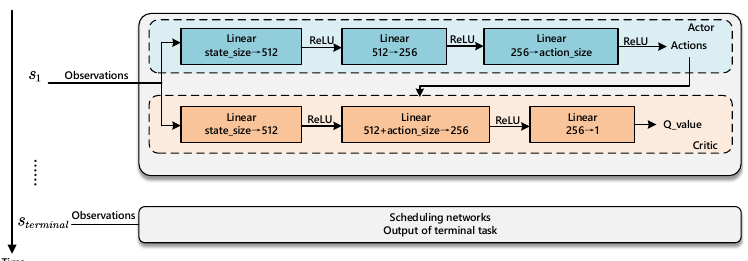
Figure 6. Architecture of DDPG actor and critic